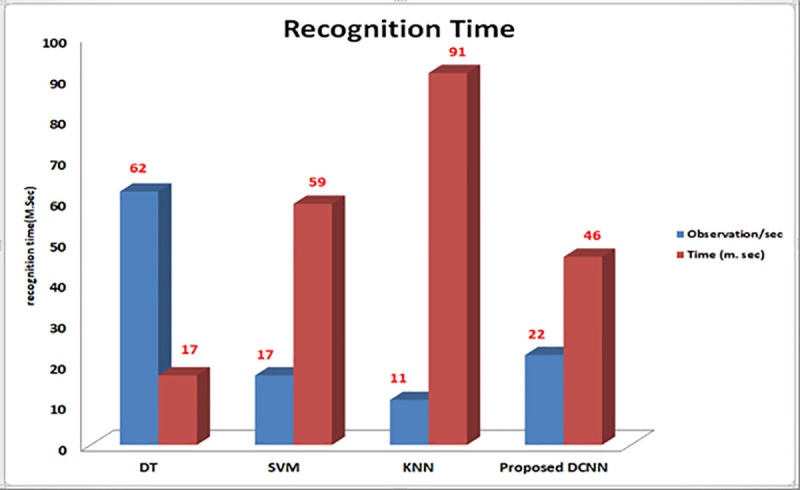
Recognition time of the proposed FR system and individual classifiers.